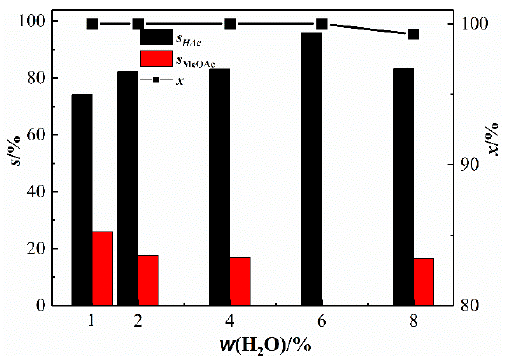
Figure 8. Catalytic performance of Rh(I)/Ru(III) bimetallic catalysts at different contents of water (T = 190 °C; p = 3.5 MPa; t = 60 min; w(CH 3 COOH) = 54 wt%; x /%: conversion rate of methanol).